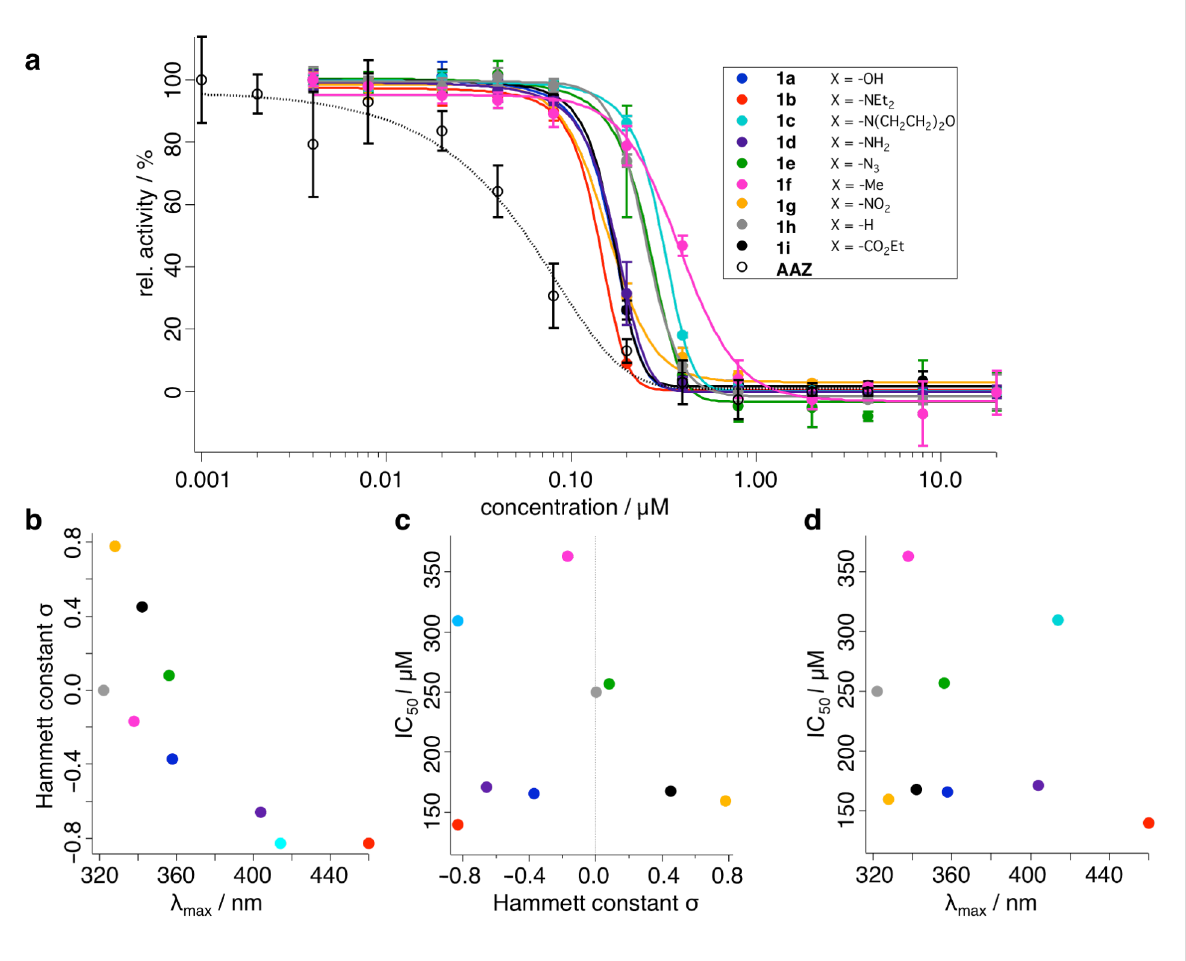
Figure 4: Inhibition of hCAII by electronically different azobenzene sulfonamides and AAZ. a) Endpoint measurement for the determination of IC 50 for compounds 1a – i . b) Hammett constants versus maximal absorbance wavelength shows decreasing trend. c) IC 50 versus Hammett constants. d) IC 50 versus λ max